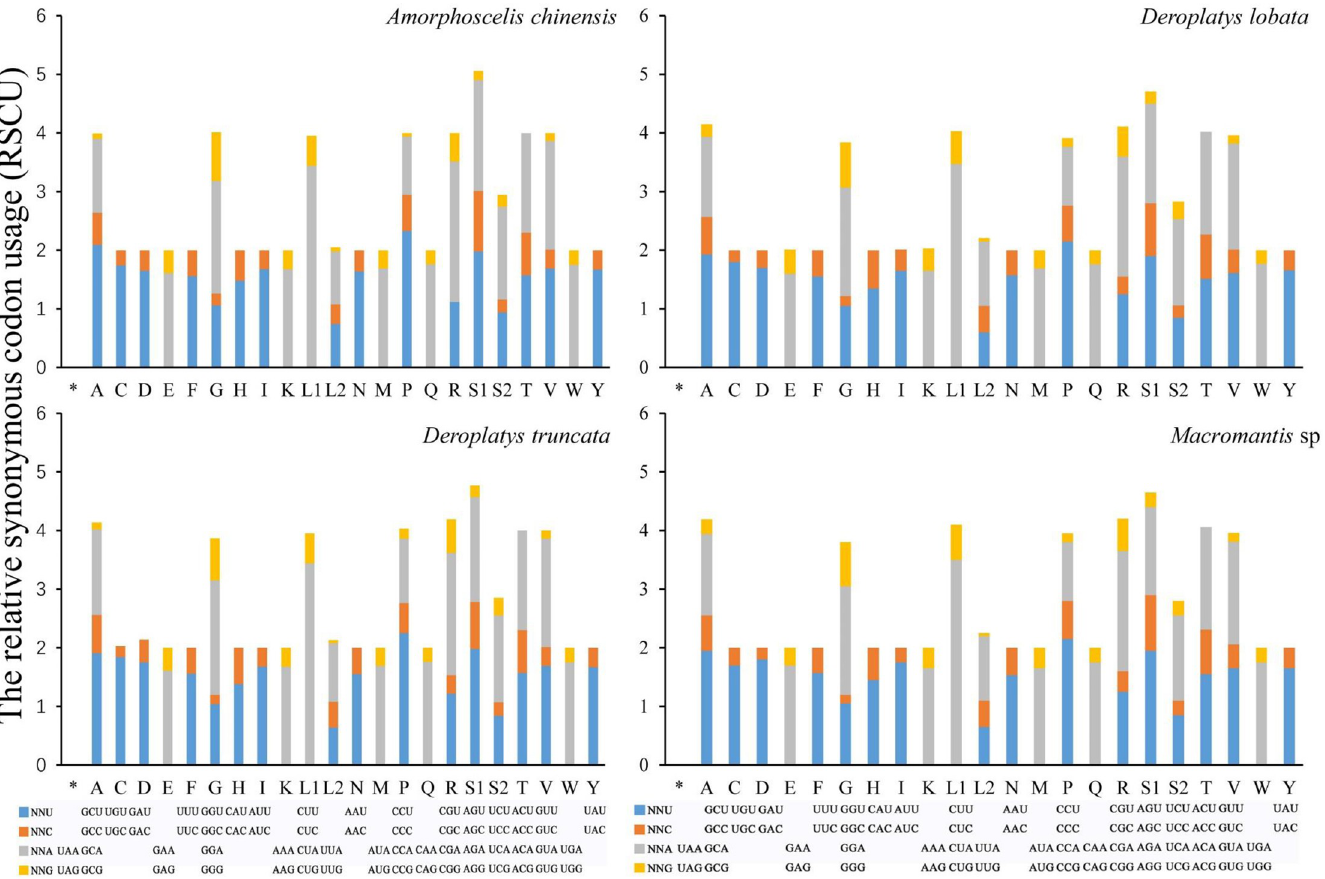
Fig 3. Relative synonymous codon usage (RSCU) for protein coding genes of five booklice. Abbreviations of tRNA genes are according to the single letter according to the IPUC-IUB one-letter amino acid